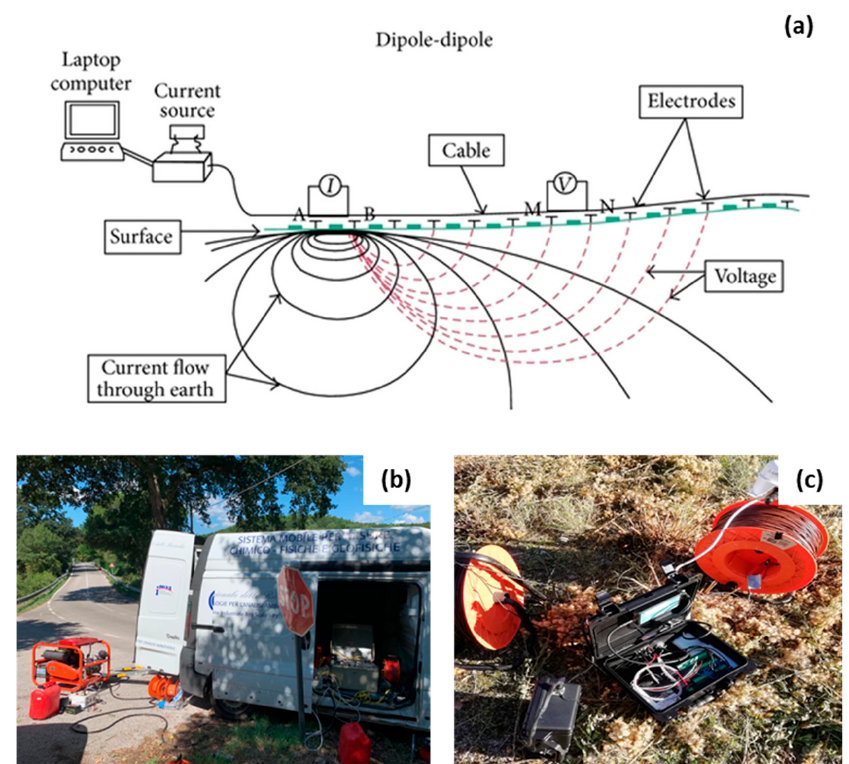
Figure 4. ( a ) Principles of the shallow DC electrical resistivity survey [85]. ( b ) DERT energizing system and ( c ) DERT measuring system.